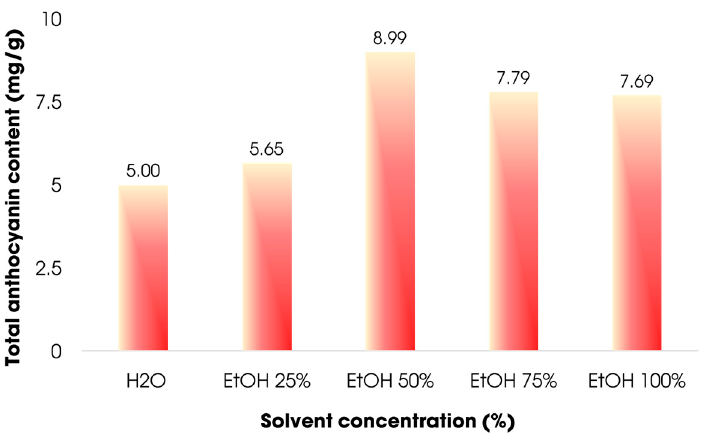
Figure 2. Extraction yields under different solvent concentrations.